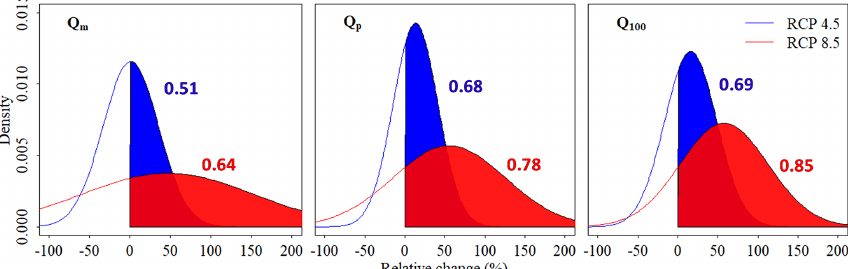
Figure 8. Probability of changes in Q m , Q p , and Q 100 at the Mission Creek watershed (no. 20 in the Fig. 7 map). The numbers in the plot are the probabilities of positive changes in Q m , Q p , and Q 100 (areas of shaded regions) under each emission scenario (blue numbers are for RCP 4.5 and red numbers are for RCP